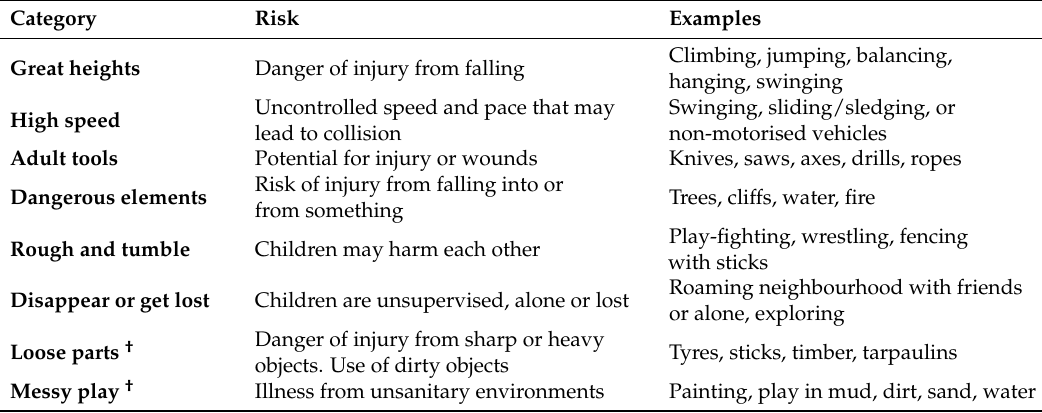
Figure 1. Participant recruitment and inclusion. Table 1. Definitions of risky play used in the State of Play Survey.